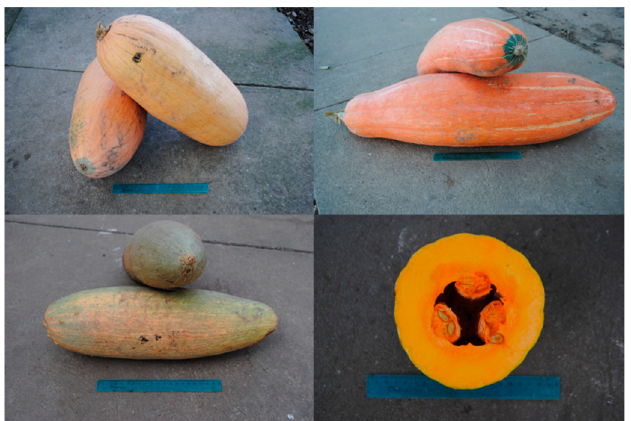
Figure 5. Mature fruits from different accessions of C. maxima Banana cultivar-group. Blue ruler 20 cm. Sliced fruit bearing three locules.